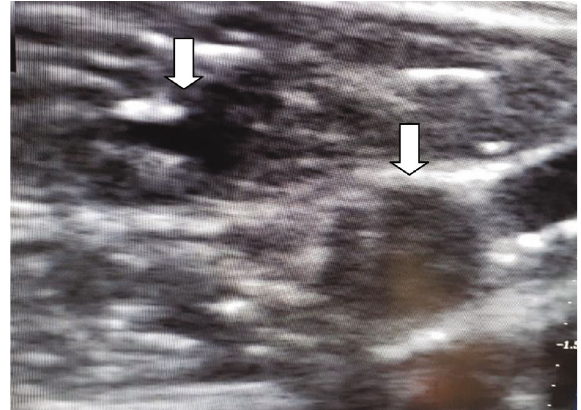
Figure 4: Thrombosed GSV and another GSV with a probe in